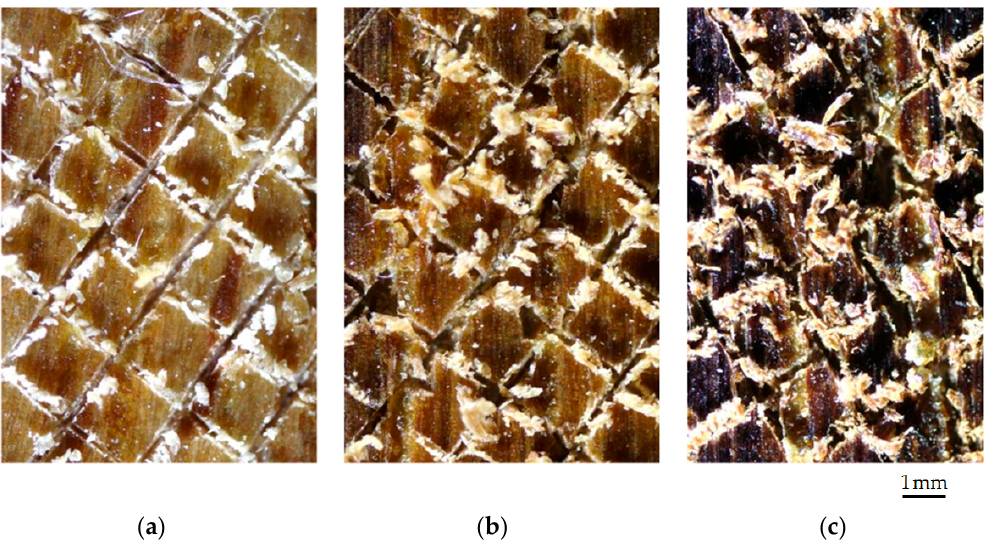
Figure 4. Adherence of wax surface finish to substrates: ( a ) on native wood (degree 2), ( b ) on thermally modified wood (TMW) 175 °C (degree 3) and ( c ) on TMW 195 °C.